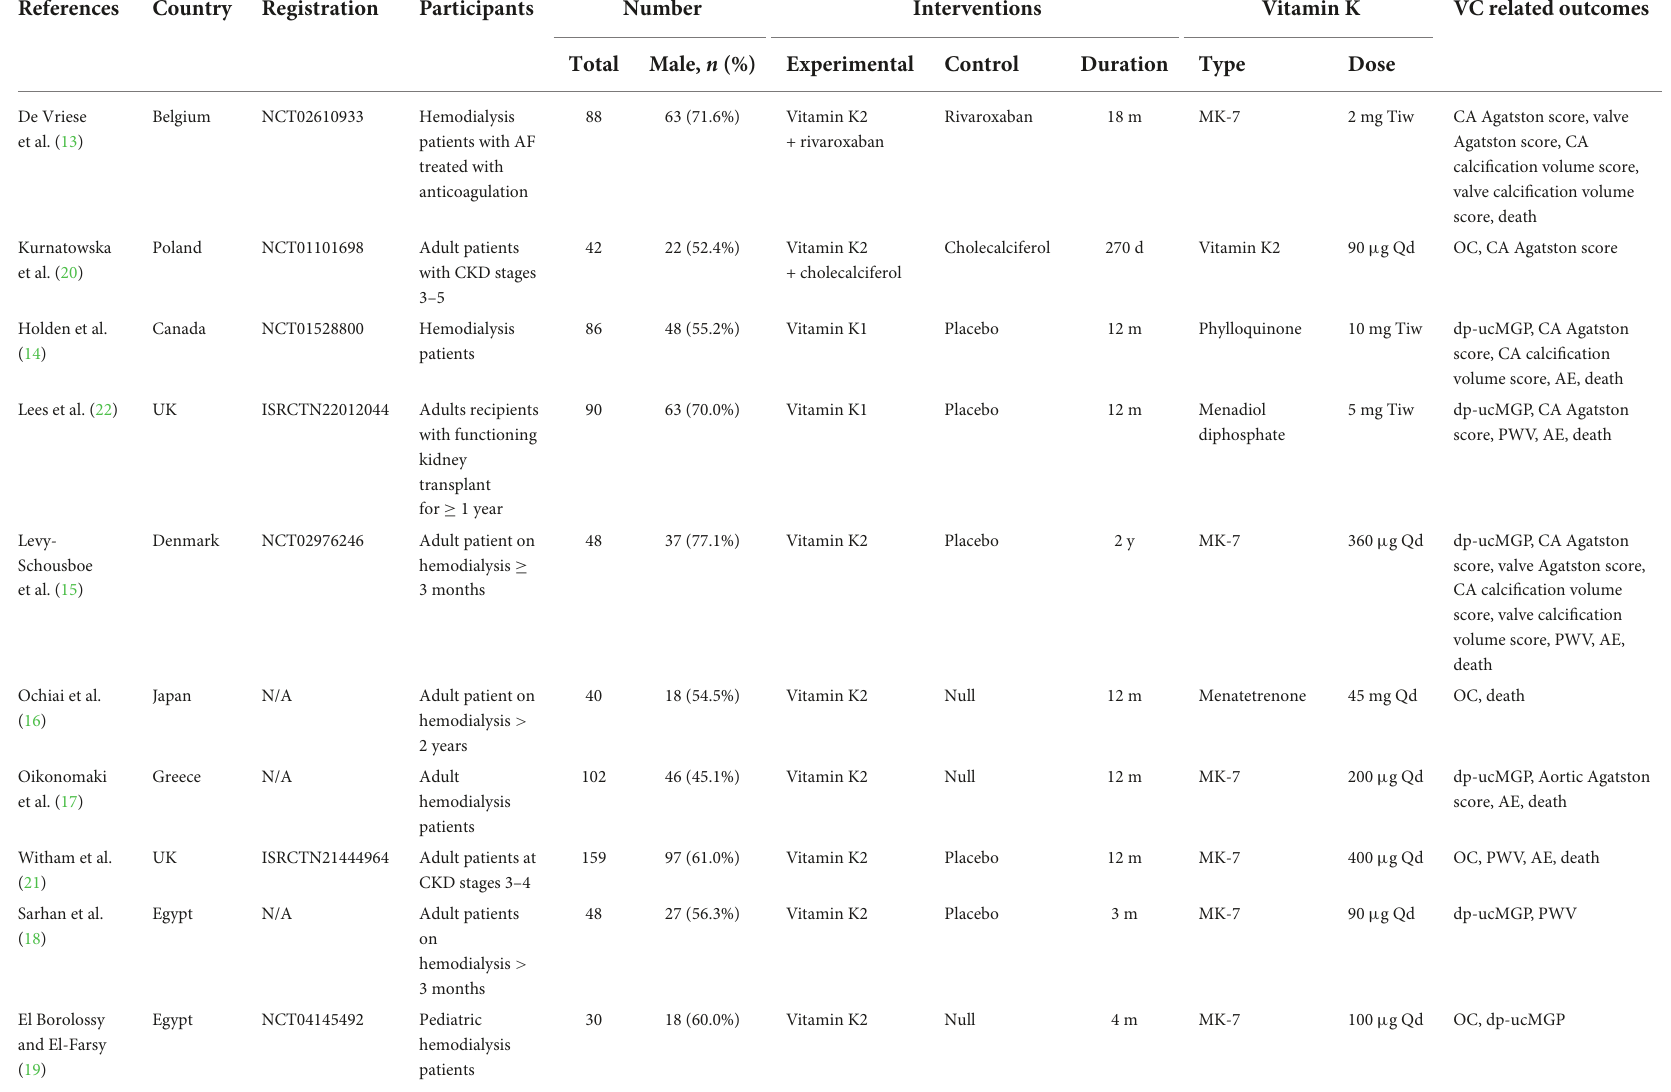
TABLE 1 Characteristics of included studies on the effect of vitamin K supplementation in chronic kidney